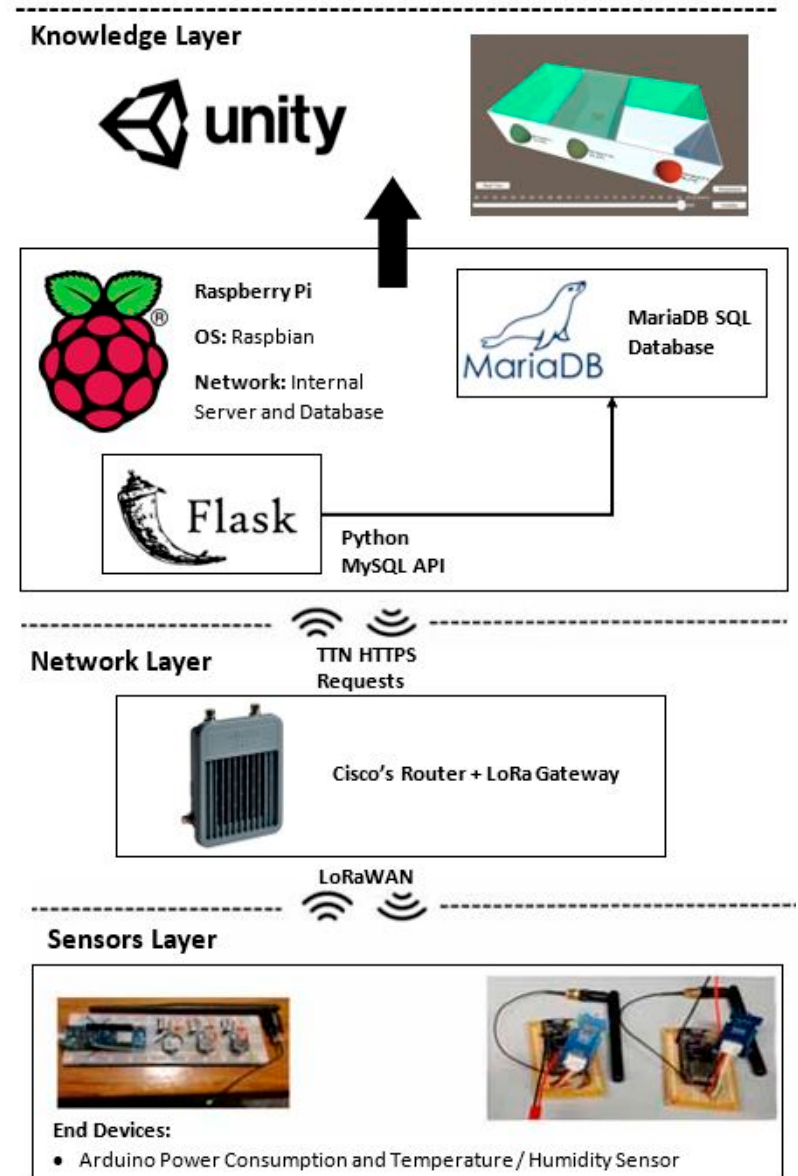
Figure 3. System architecture developed for real-time measurement of energy, temperature, humidity, and energy consumption.